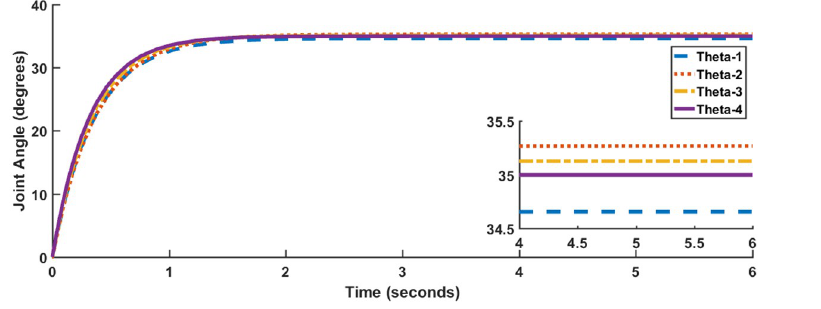
Fig 4. Response for LQR, Case I.